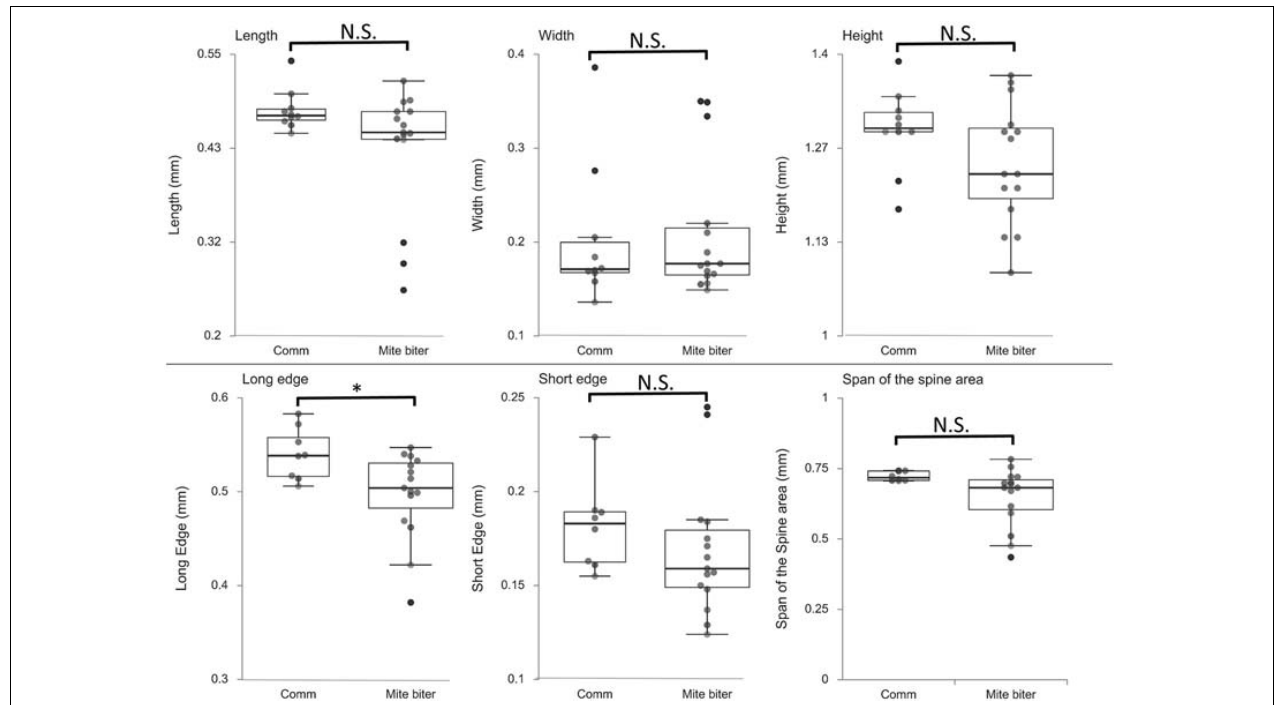
FIGURE 7 | Box plots of the six parameters of mandible morphology between two groups, commercial colonies (Comm, N mandible = 10) and mite-biter colonies (mite biter, N mandible = 15). Each filled circle represents a data point. Results of the one-way ANOVA suggest that the two treatments were not significantly different in length, width, height, short edge, or span of the spine area, but they were significantly different in the long edge, F (1,21) = 5.78, p <